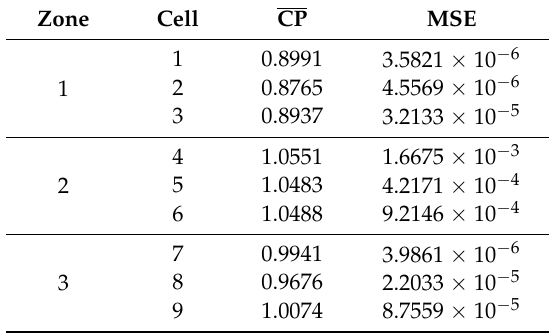
Table 3. Mean of CPs obtained using the proposed approach (CP) and the mean square error (MSE) between CPs extracted using ImageJ-Supervised Tracking and our automatic tracking proposal. Mechanical stimulus experiment.